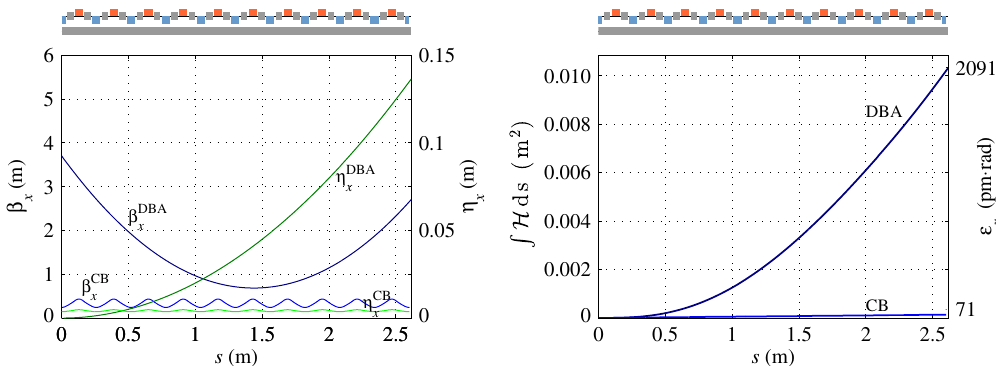
FIG. 3. Comparison between the NSLS-II bending dipole and the complex bend. The left plot shows the beta function and dispersion, and the right plot presents the integral of the H -function from 0 to s for the two cases. The corresponding emittance values are shown on the right scale of the right plot (2.1 nm rad is the natural NSLS-II lattice emittance).